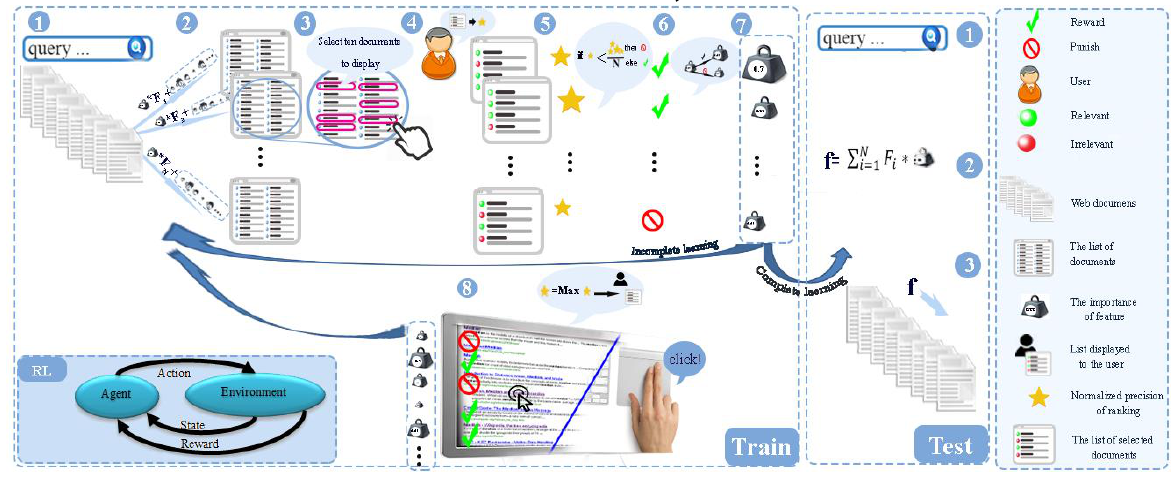
Figure 2. General overview of the RRLUFF